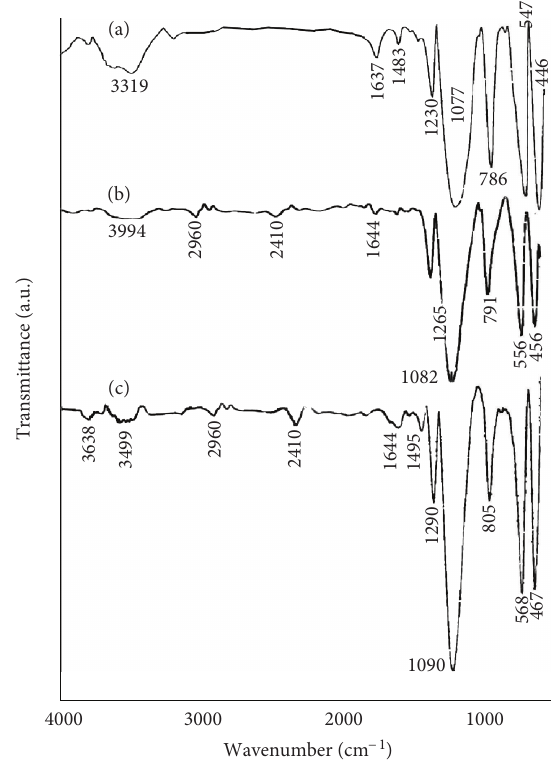
F 3: FTIR spectra of Na-ZSM-5 (a), Ni-ZSM-5 (b), and Ni- DMG/ZSM-5